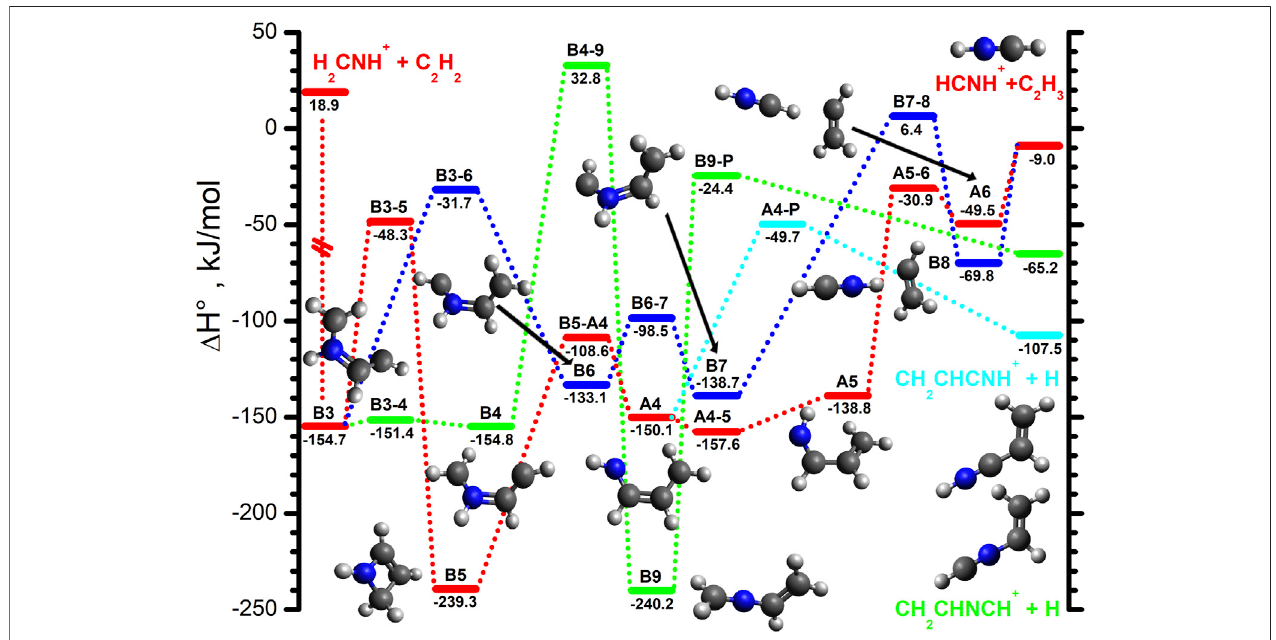
(cid:129) plus C 2 H 2 . Energies (in kJ/mol) are de fi ned with respect to the separated HCNH 2+